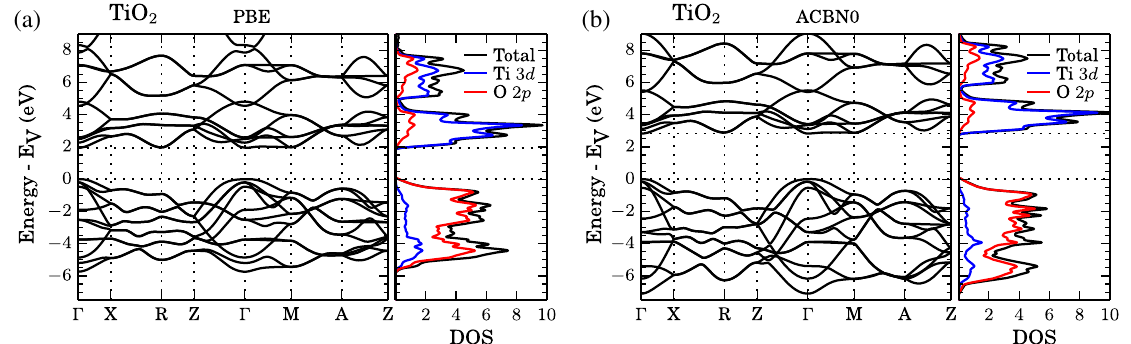
FIG. 1. Comparison between the band structures and projected density of states of TiO 2 without on-site interactions U ¼ 0 (a) and with the converged effective values of U ¼ 0 . 15 eV for Ti and 7.34 for O (b).